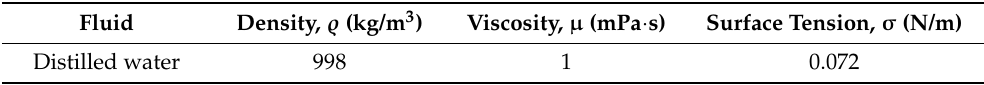
Table 1. Physical properties of the liquid used in this study (at 20 ◦ C).